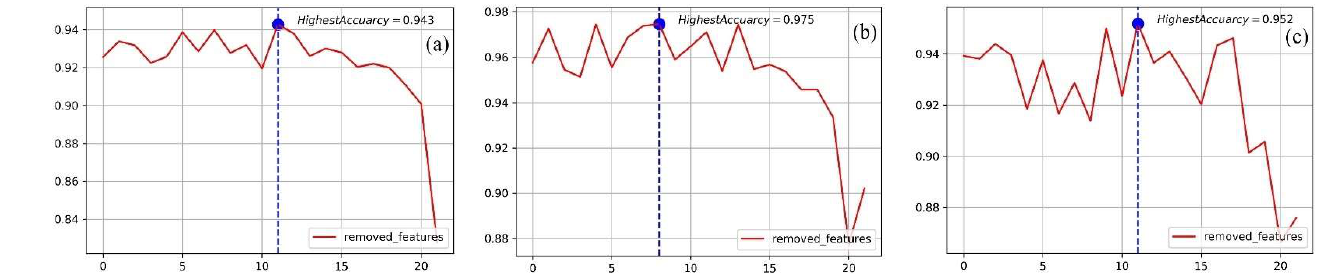
Figure 9. AUC changing curves of wrapper-MDI feature selection method. These results reflect the different numbers of remaining features in the dataset while the model obtained the highest AUCs. ( a ). Landslide; ( b ) Collapse; ( c ) Unstable slope.